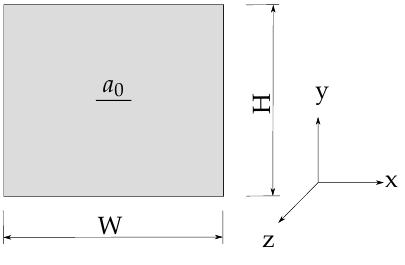
Figure 1. Specimen with centre